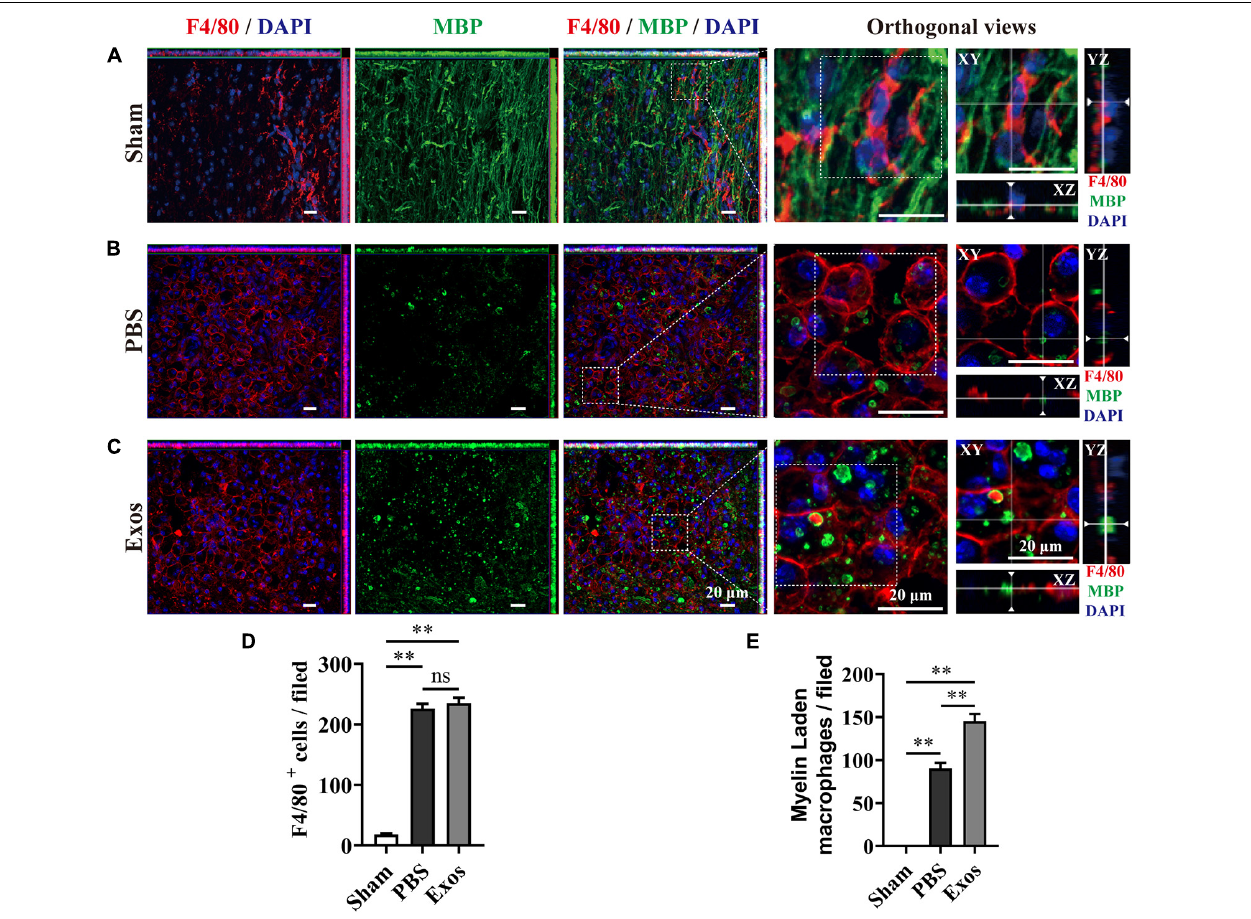
FIGURE 3 | Bone marrow mesenchymal stem cell-derived exosomes (BMSC-Exos) promoted macrophage phagocytosis of myelin debris after spinal cord injury. (A) Representative immunofluorescence images of the macrophage marker F4/80 (red) and myelin marker myelin basic protein (MBP) (green) in the spinal cord tissue of the sham group. (B,C) Representative immunofluorescence images of myelin debris (MBP, green) uptake by macrophages (F4/80, red) in the lesion site of the spinal cord in the phosphate-buffered saline (PBS) and BMSC-Exos groups at 7 days post-spinal cord injury (post-SCI). Nuclei were counterstained with DAPI (blue). Scale bar = 20 µ m. (D,E) Quantification of macrophages (F4/80, red) and myelin-laden macrophages (F4/80, red and MBP, green) in the lesion site at 7 days post-SCI ( n = 5 per group, values are the mean ± SD, ns indicates no significance, ∗∗ p < 0.01, one-way